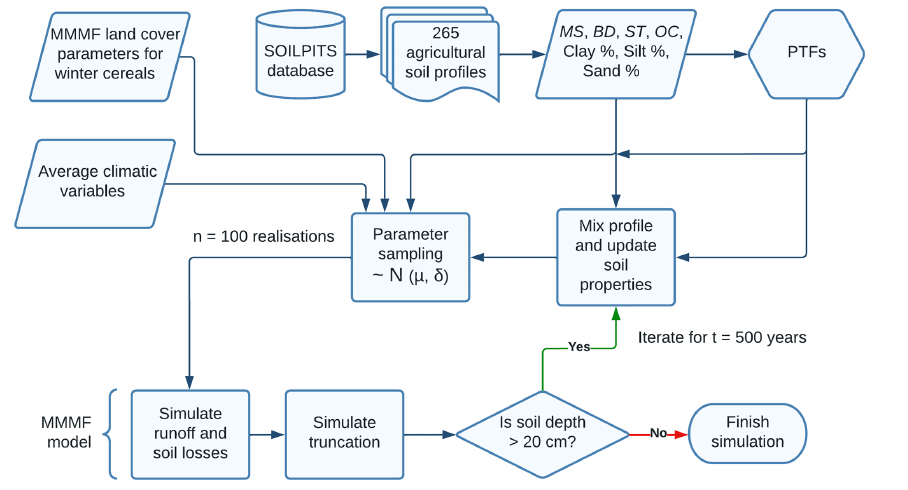
Figure 4. Flowchart of the modelling